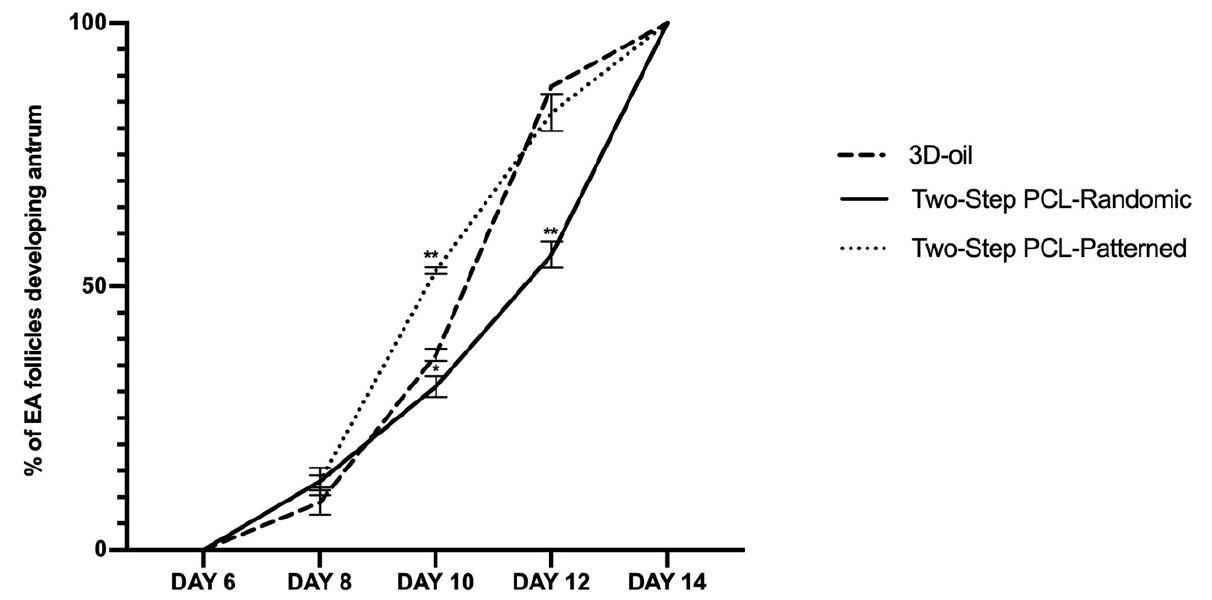
Figure 6. Development trend of the follicular antrum over time according to follicular treatment